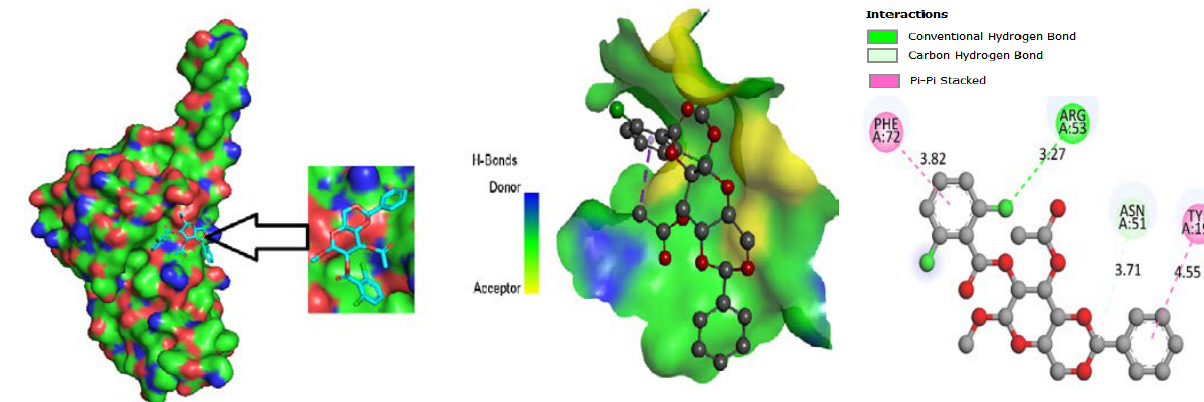
Figure 3. Molecular docking poses of envelope protein WSSV (PDB: 2ED6) with L04.